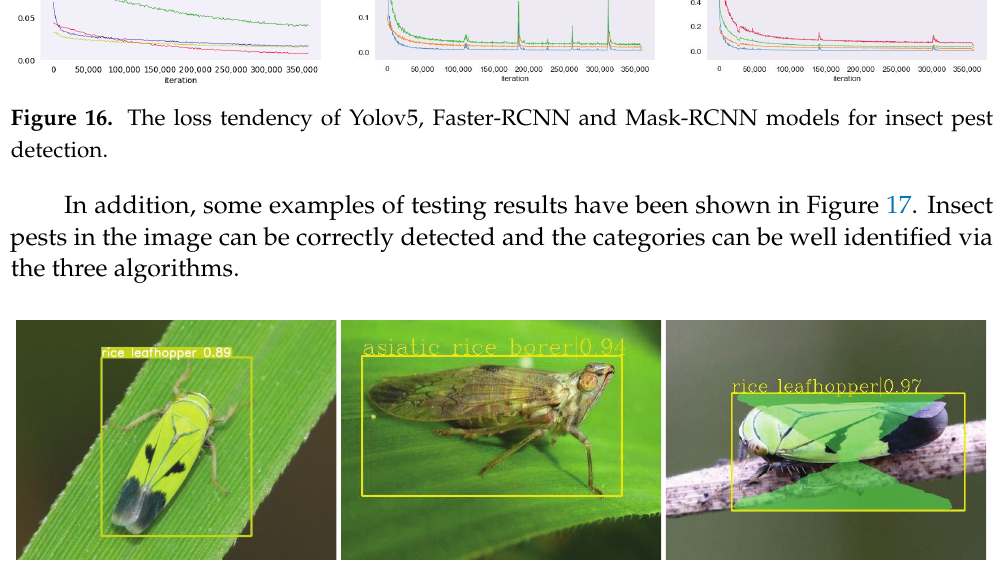
Figure 17. Some examples of testing results of Yolov5, Faster-RCNN and Mask-RCNN models for insect pest